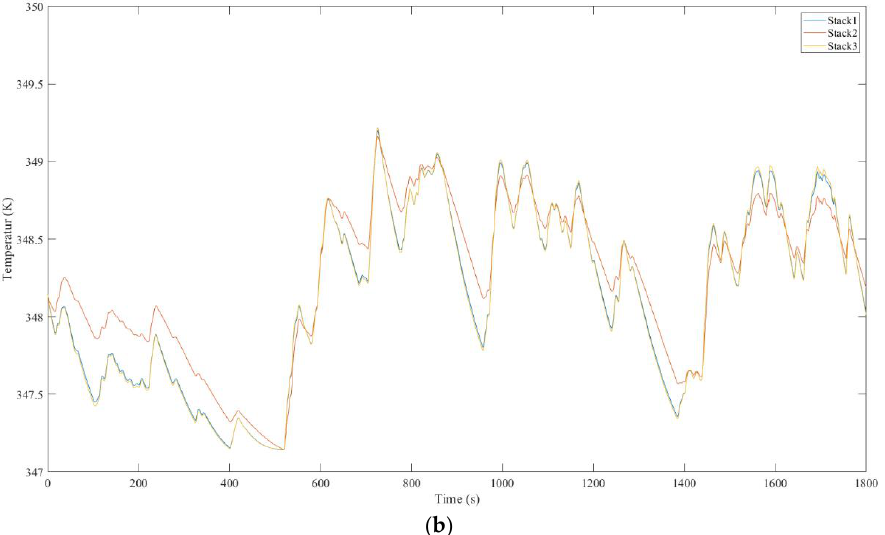
Figure 17. Three stacks ’ temperatures of the two topologies under variable working conditions: ( a ) distributed topology and ( b ) integrated topology.